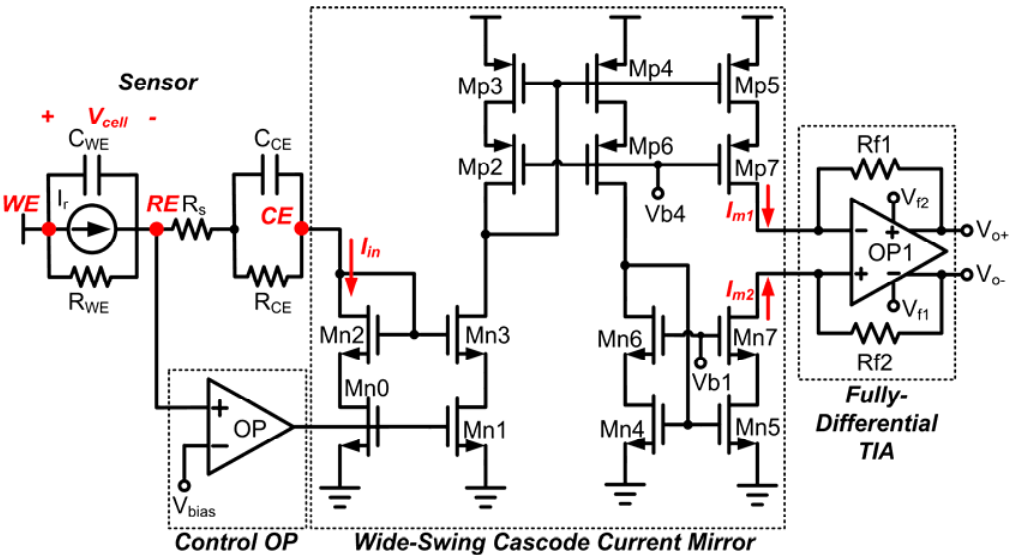
Figure 6. The transistor level schematic of the fully-differential